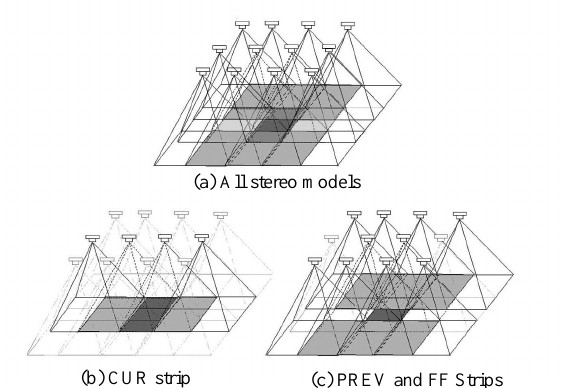
Figure 4 Combination of the stereo models for use of the RPM